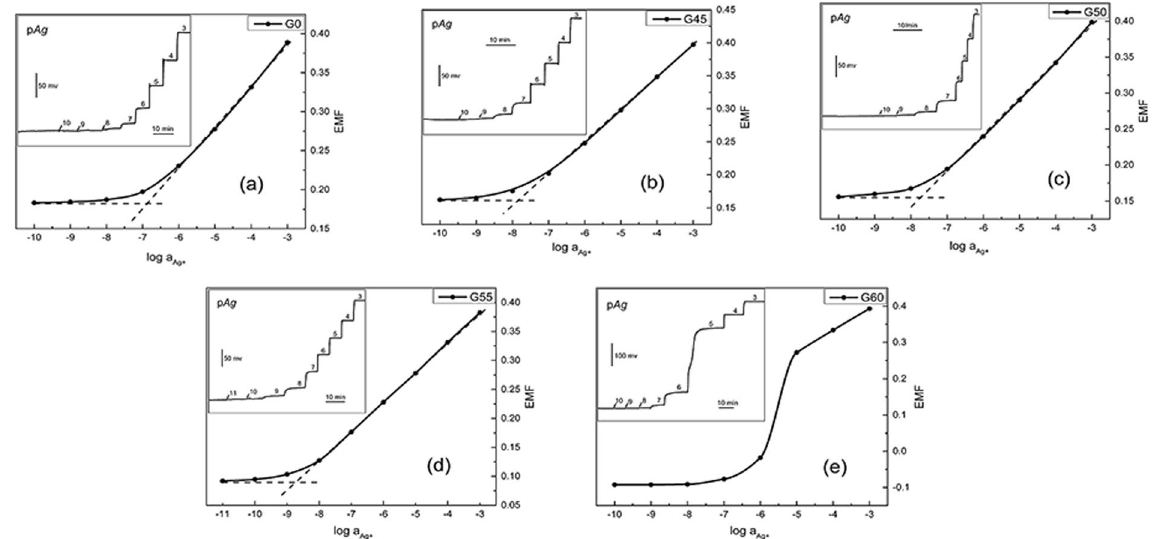
Figure 3. Calibration curves of all ISEs. The dotted lines are least-squares fits. Inset: time traces of the response of all ISEs.